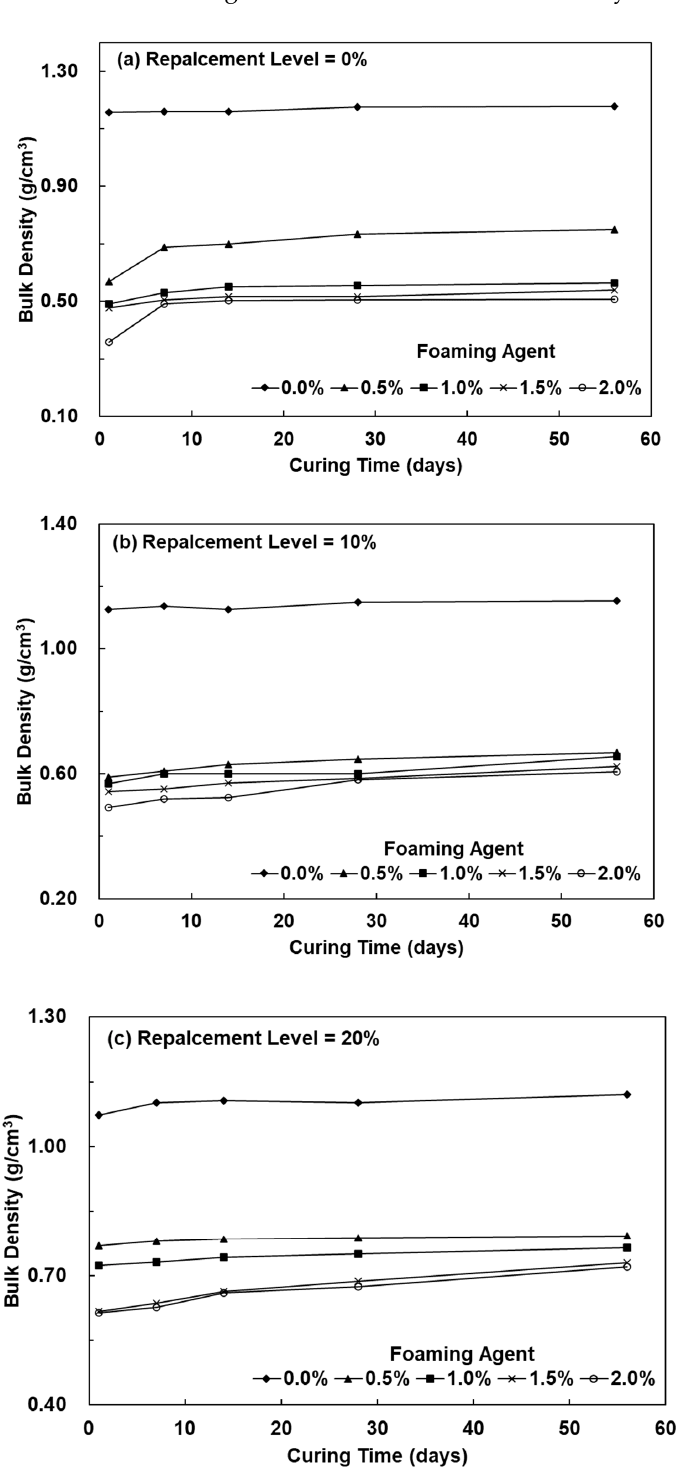
Figure 1. The bulk density of lightweight FGPs with SCS replacement levels. ( a ) 0%; ( b ) 10% and ( c )